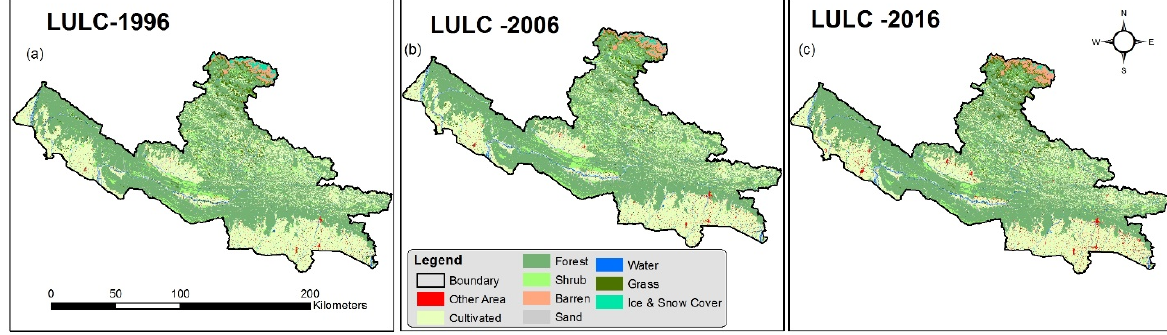
Figure 3. LC map of Lumbini Province ( a ) 1996; ( b ) 2006; ( c ) 2016.